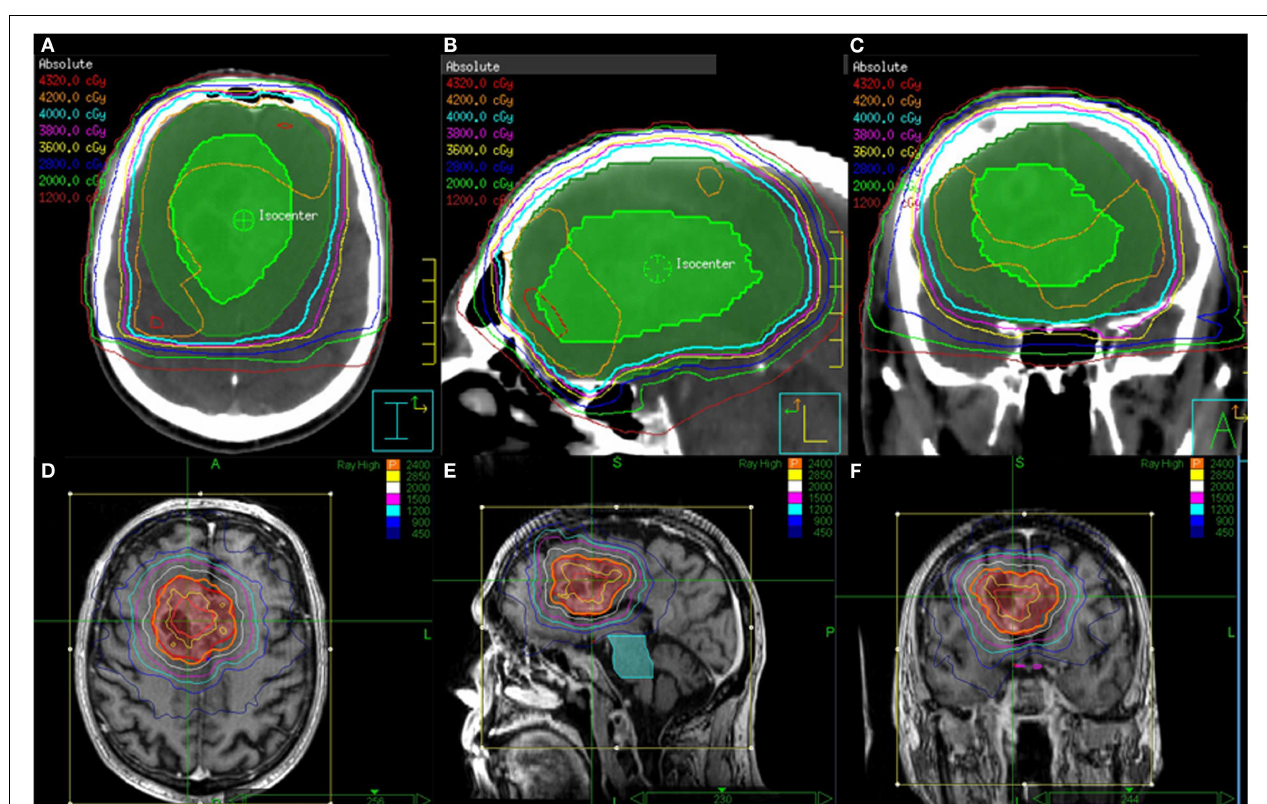
FIGURE 1 | EBRT and CyberKnife SRS treatment plans for a patient who received 40Gy in 15 fractions to FLAIR for the first course followed an SRS boost toT1 Enhancement at a total dose of 24Gy delivered in 3